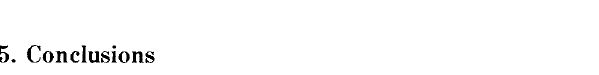
Vander Waals forces between two spherical particles under (i) smooth contact and (ii) rough contact condi